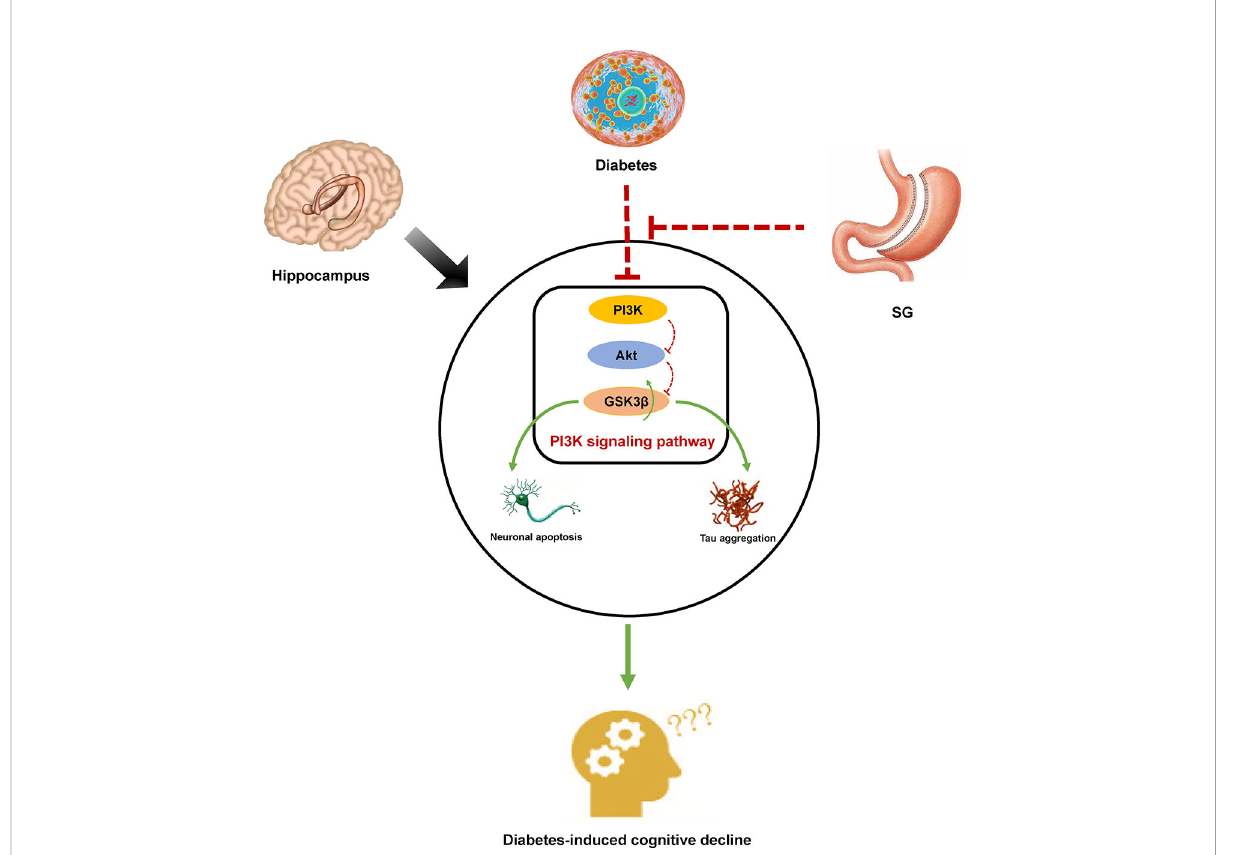
FIGURE 6 Diagram of a possible mechanism by which SG improved DCD. In DM rats, inhibition of PI3K signaling resulted in histological changes in the hippocampus by promoting tau phosphorylation and inducing apoptosis of hippocampal neurons. Activation of PI3K signaling pathway was associated with SG-induced amelioration of